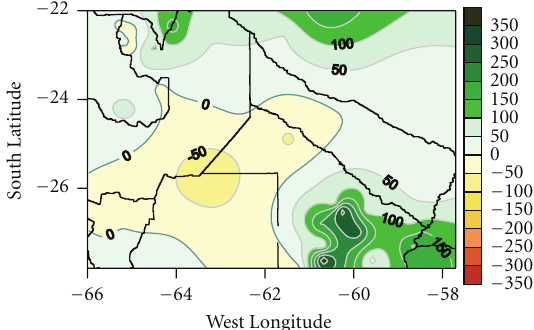
Figure 9: Rainfall anomaly in SON 1994. Anomalies are calculated from 1961–2010 seasonal